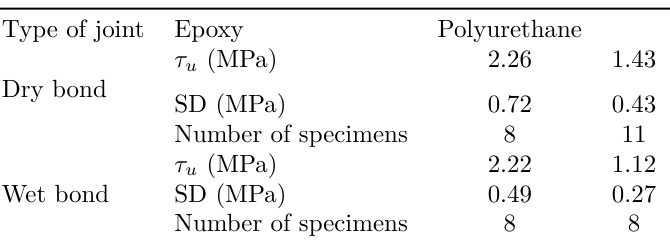
Table 4. Shear strength ( τ u ) and standard deviation (SD) of timber-prefabricated and timber-cast-in-situ glued joints.